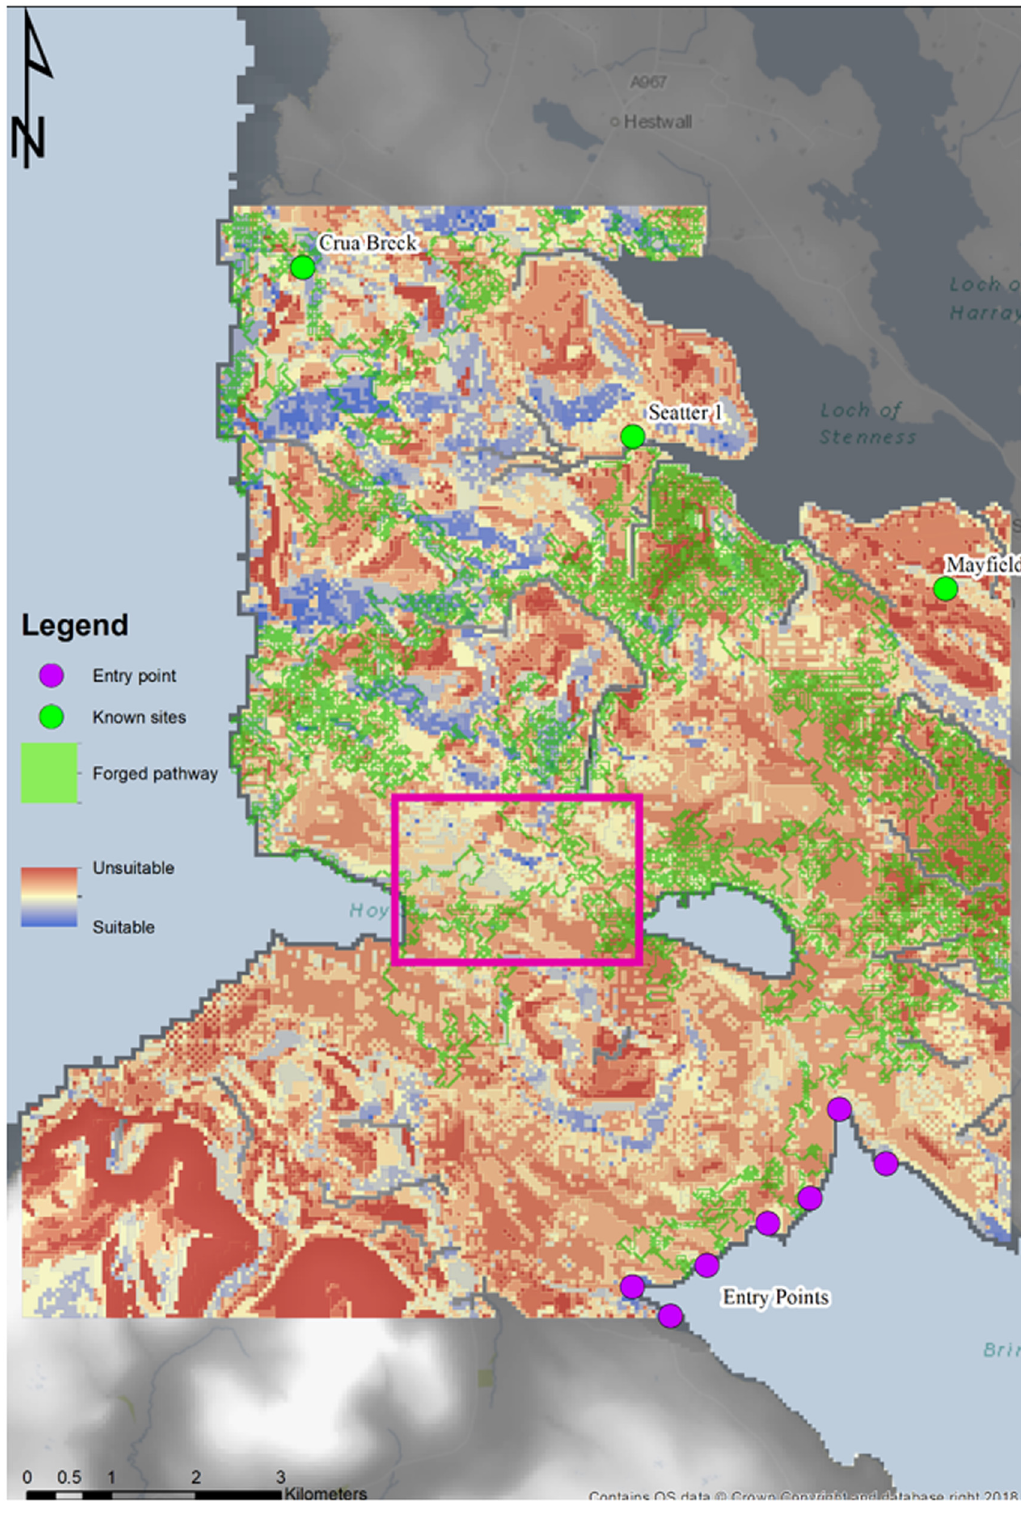
Figure 5: An example of the ABM generated pathway ( green ) on top of the settlement suitability prediction map. Potential movement corridor highlighted in